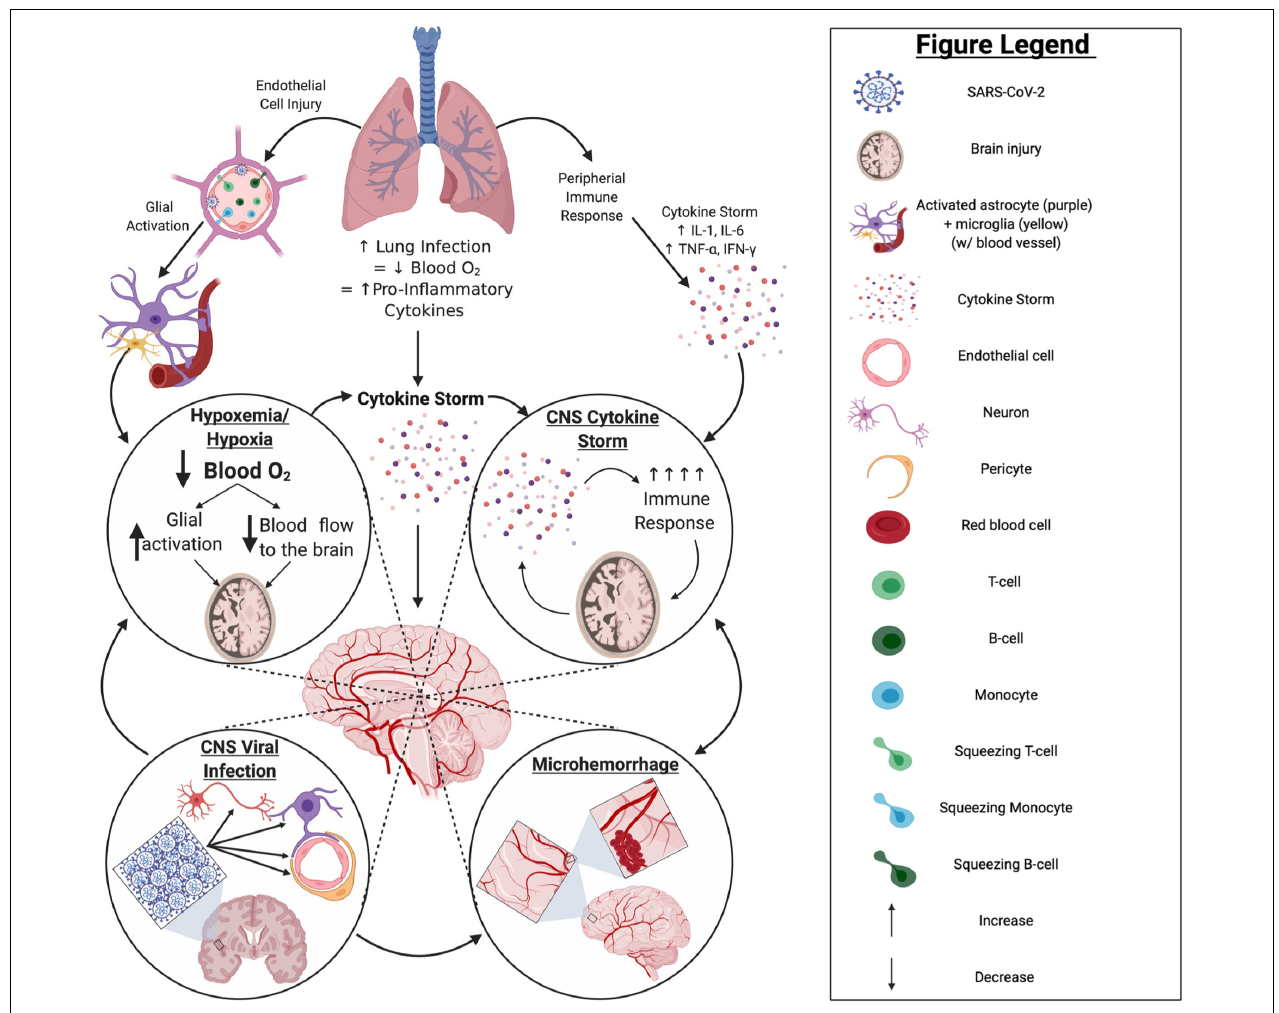
FIGURE 9 | COVID-19 pathology in the CNS: primary impacts and potential mechanisms. Infection by SARS-CoV-2 primarily impacts the lungs, often leading to a hypoxic state and resulting in a robust increase in proinflammatory cytokine production. This may ultimately cause a “cytokine storm” and/or activate glia in the